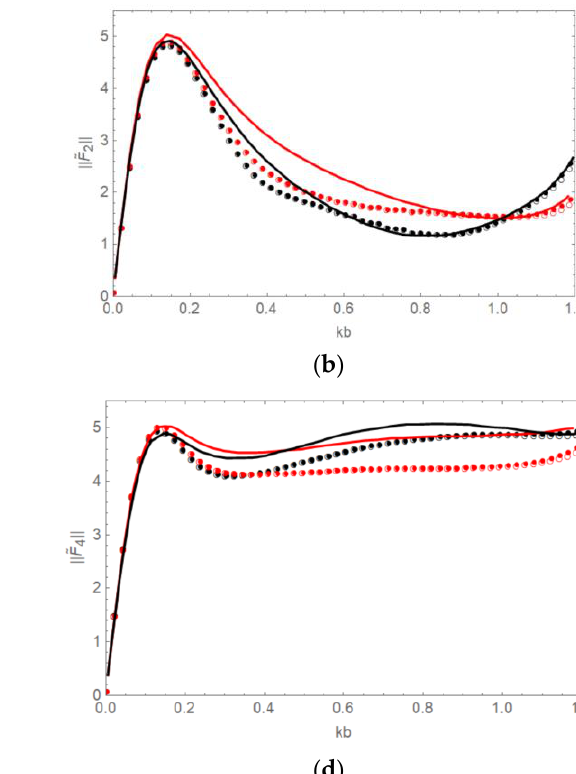
Figure 4: Non-dimensional total wave forces ( a ) acting on the cylinders in Figure 2 with d / b = 2, h i = 1 m are shown in red ( β = 30 ◦ ) and black ( β = 45 ◦ ). Ren et al. [19] (solid line), present solution with five (empty circle) and ten (filled circle) vertical modes, respectively.